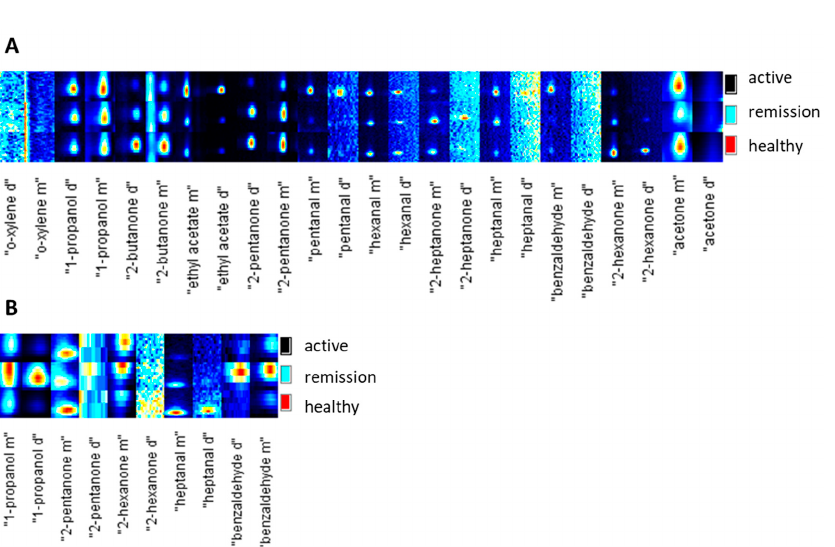
Figure 4. Intensity comparison of the compounds identified in the urine ( A ) and serum ( B ) samples of each category.